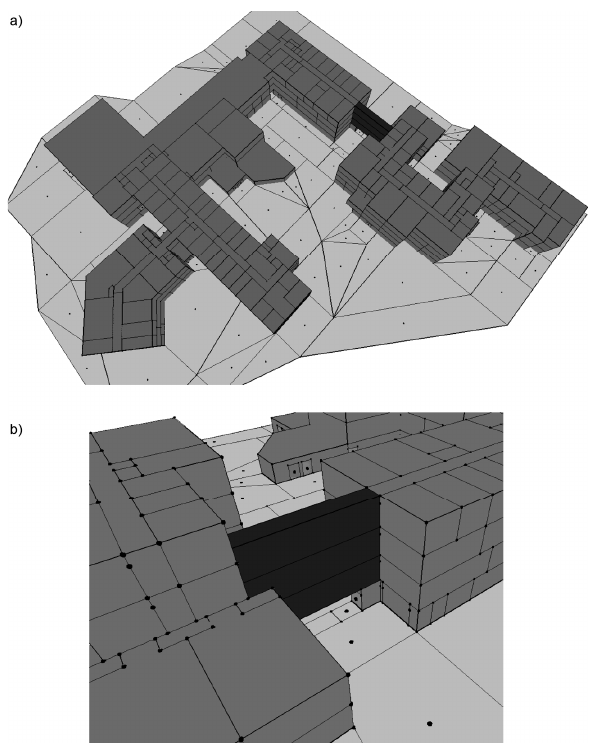
Figure 17. Two buildings from the University of Glamorgan campus connected by an above-ground passage modelled using the DHE data structure: ( a ) light-grey cells represent terrain, grey cells represent rooms, dark-grey cells represent the above-ground passage between buildings; ( b ) an above-ground passage between two buildings—dark cells.